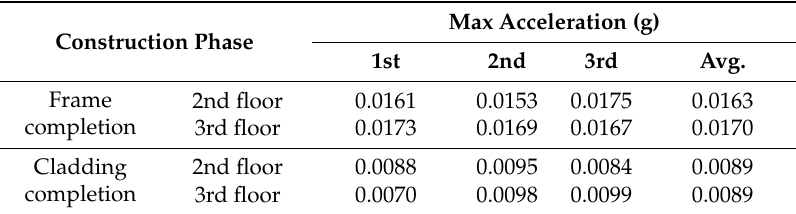
Table 8. Maximum acceleration (Sangsoo-dong building).